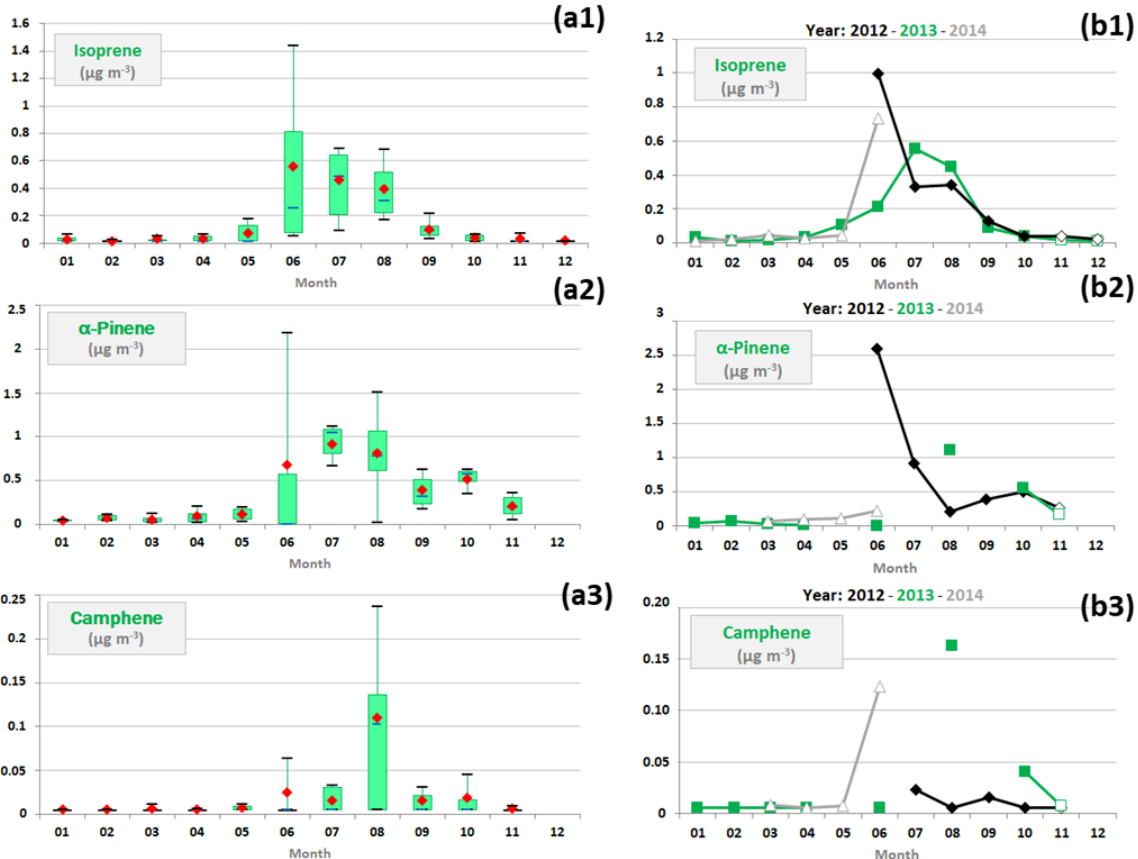
Figure 4. (a) Monthly variations in a selection of biogenic VOC concentrations (expressed in µgm − 3 ) represented by box plots; the blue solid line, the red marker, and the box represent the median, the mean, and the interquartile range of the values, respectively. The bottom and top of the box depict the first and third quartiles and the ends of the whiskers correspond to the first and ninth deciles. (b) Their monthly average concentrations as a function of the year; full markers indicate months when VOC samples were collected from 12:00 to 16:00UTC and empty markers those when VOC samples were collected from 09:00 to